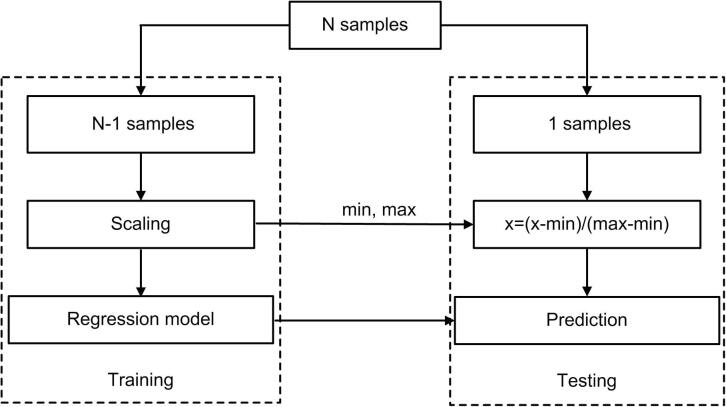
Schematic overview of one loop of leave-one-out cross-validation (LOOCV) prediction framework. One subject was used as testing and the remaining subjects were used as training dataset. Each feature was linearly scaled between zero and one across the training dataset, and the scaling parameters were also applied to scale the testing dataset. Relevance vector regression was used to train a model, which was used to predict the PSQI of the testing subject.